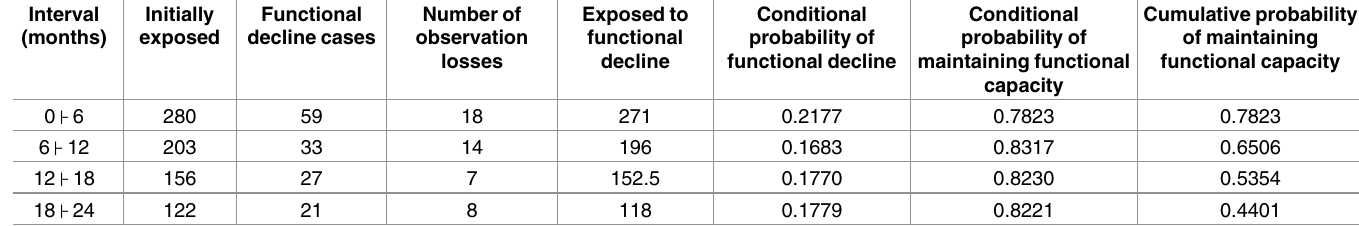
Table 2. Probability of maintaining functional capacity by the actuarial method (incident cases of functional decline in institutionalized older adults in Natal/RN). Natal/RN, 2016. Interval (months)